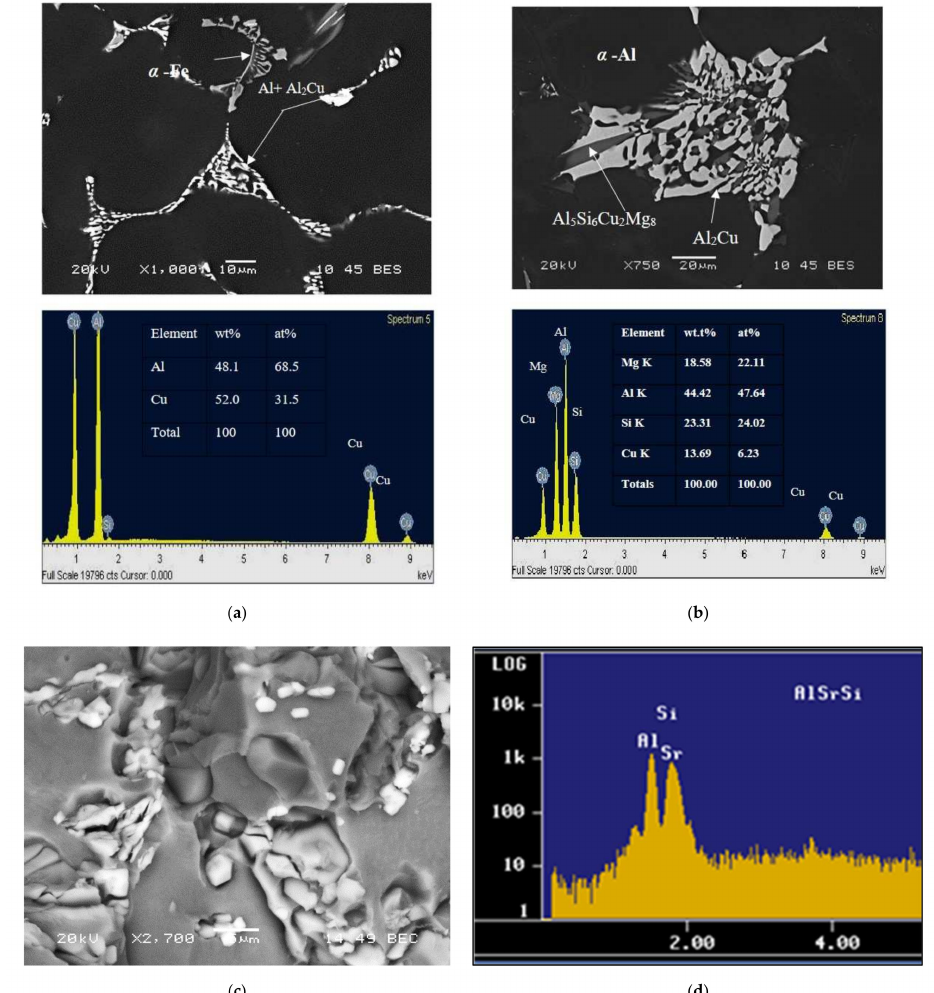
Figure 12. Backscattered electron micrographs and their corresponding EDX analyses, showing ( a ) segregation of the Al 2 Cu phase; ( b ) the formation of thick particles/platelets of Al 5 Si 6 Cu 2 Mg 8 phase in grain-refined and heat-treated Al-11%Si alloys containing high levels of Cu and Sr, ( c ) precipitation of excesses of Sr, ( d ) EDS spectrum of Sr in black circle in ( c